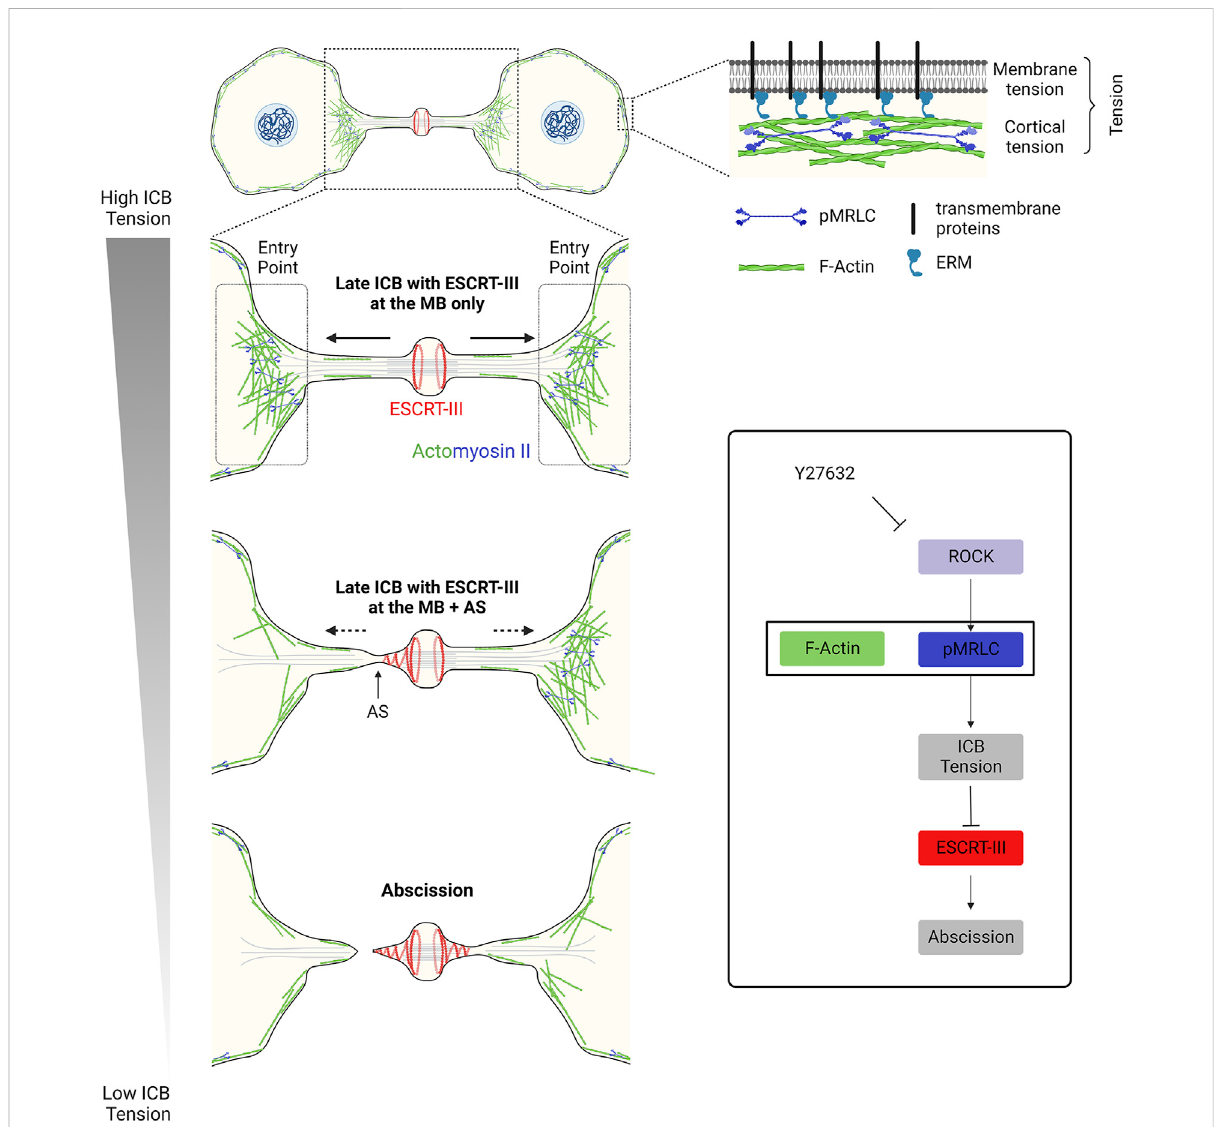
FIGURE 2 – Decrease in tension at the ICB triggers ESCRT-III polymerization and successful abscission in epithelial cells. Left panel: Decrease in the ICB tension and reduction of actomyosin contractility at the Entry Points (EPs) allow ESCRT-III polymerization, as cells progress towards abscission. Top rightpanel:Tensionresultsfromacombinationofmembranetensionandactomyosin-dependentcorticaltension.Box:Schematicsummarizingthe contribution of the actomyosin network to the ICB tension, ESCRT-III polymerization and abscission. Y27632: drug that inhibits ROCK and prevents the phosphorylation (activation) of myosin